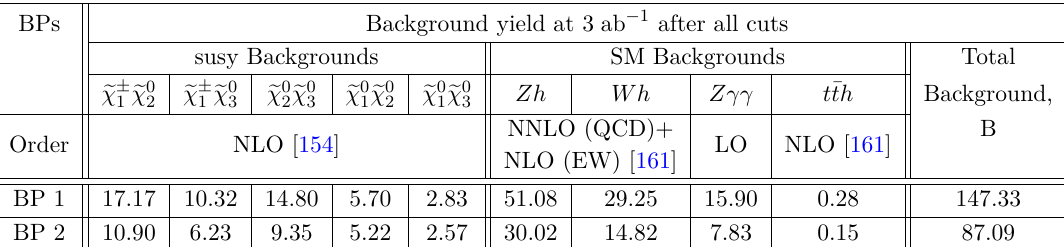
Table 20. The cut-flow table for the benchmark point 1 in the γγ + /E production and backgrounds.